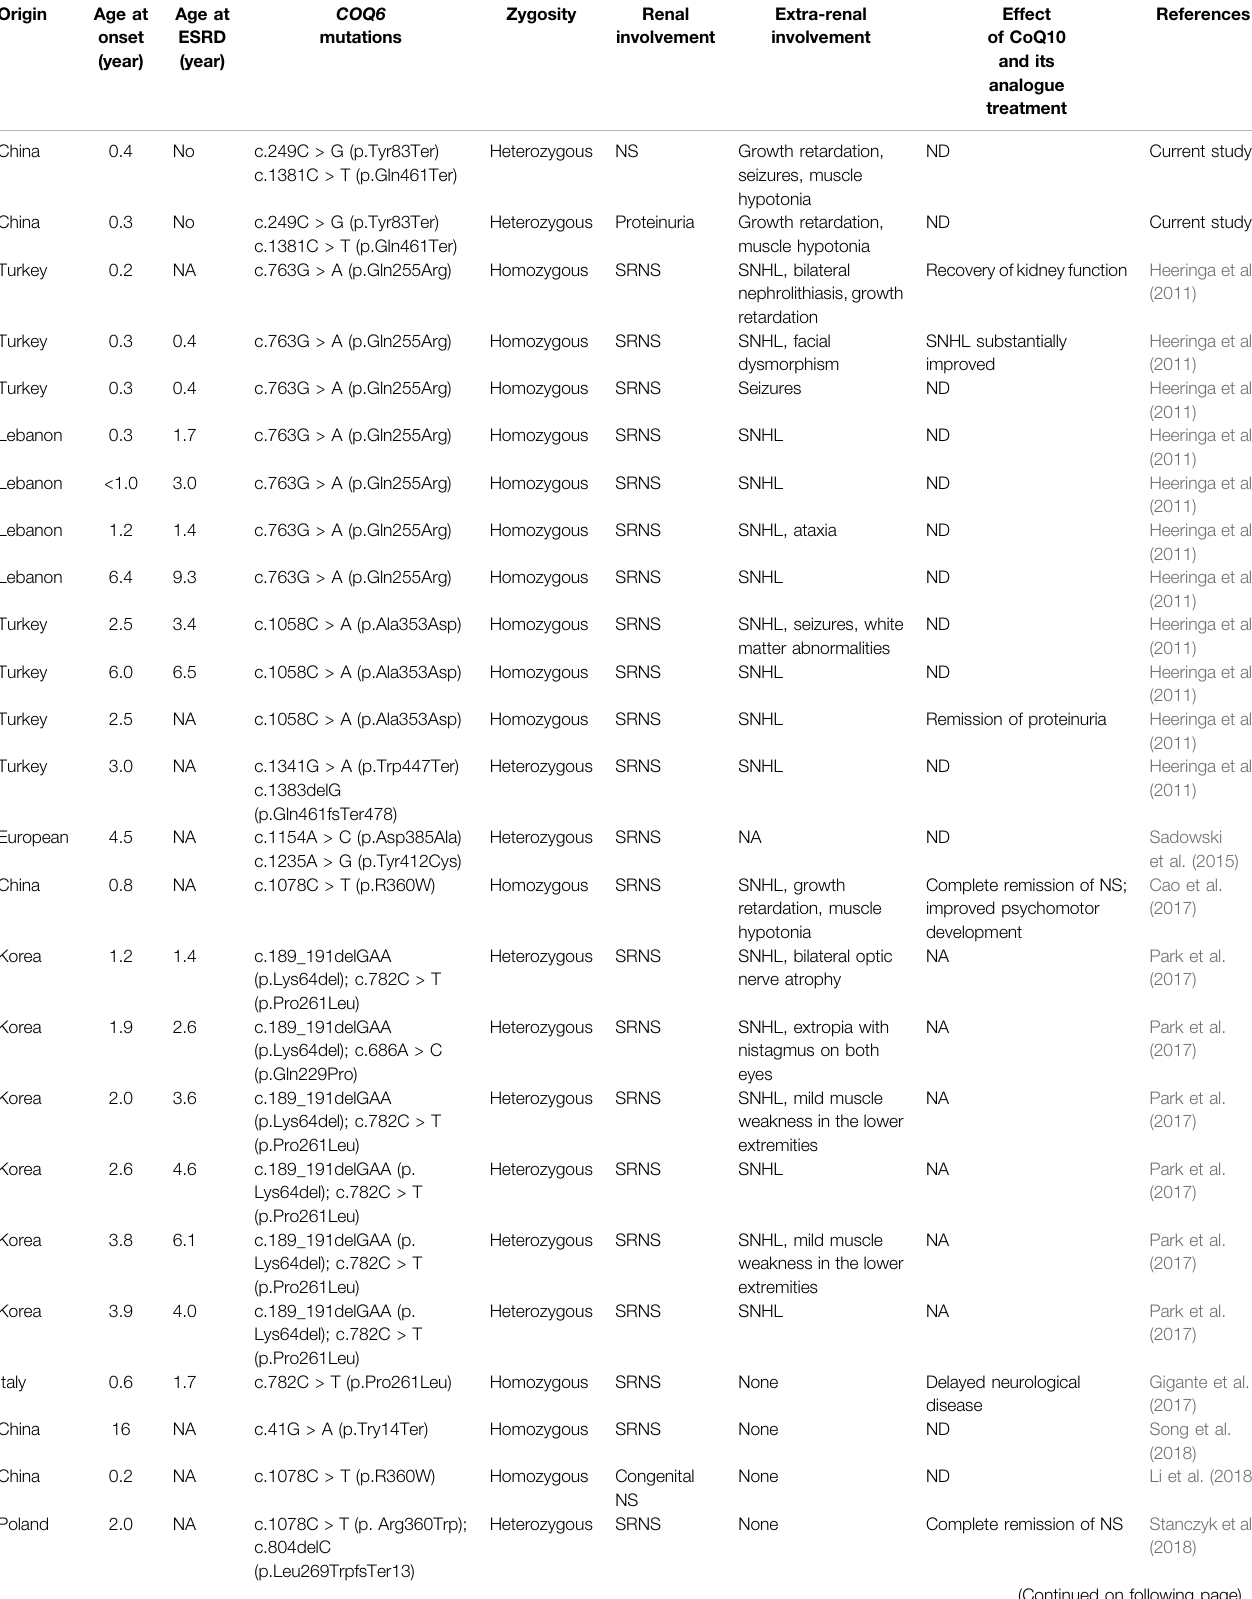
TABLE 2 | Genotypic and phenotypic characteristics of the detected COQ6 variants in the published literature and the present study.